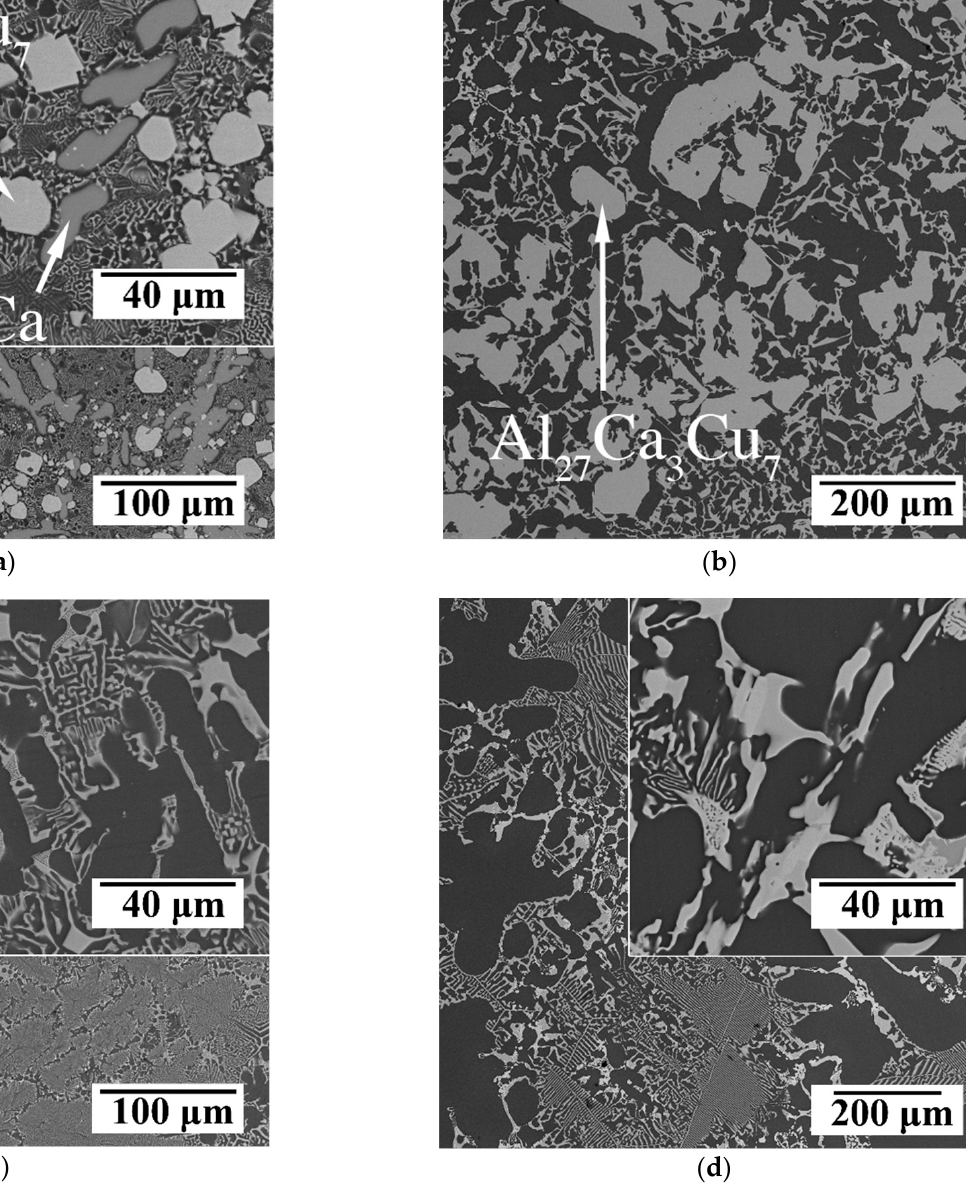
Figure 3. SEM microstructure of the alloys: ( a , b ) Al18Cu6.0Ca, ( c , d ) Al14Cu2.5Ca, for cooling rates of ( a , c ) 10 K/s, and ( b , d ) 0.02 K/s. BSE. Finally, the structure of the hypoeutectic alloys with primary aluminum solid solu- tion (Al) crystals was studied. One can see that the Al3.4Cu5.6Ca, Al5.6Cu3.5Ca and Al9.0Cu3.5Ca alloys have a fine hypoeutectic structure (Figure 6). The alloys were also obtained at slow solidification, which coarsens the structural components. The latter fact makes it possible to carry out spectral analysis to determine the chemical composition of crystals. The data (Table 2) suggest that the eutectic in the alloys consists of the (Al,Cu) 4 Ca and Al 27 Ca 3 Cu 7 phases. An XRD analysis of the Al5.6Cu3.5Ca alloy (Figure 4) confirmed the presence of these extra phases. Due to the relatively fine structure of the crystals, the measured composition of the Al 27 Ca 3 Cu 7 crystals is somewhat different from the one accepted in [25], but it can still be